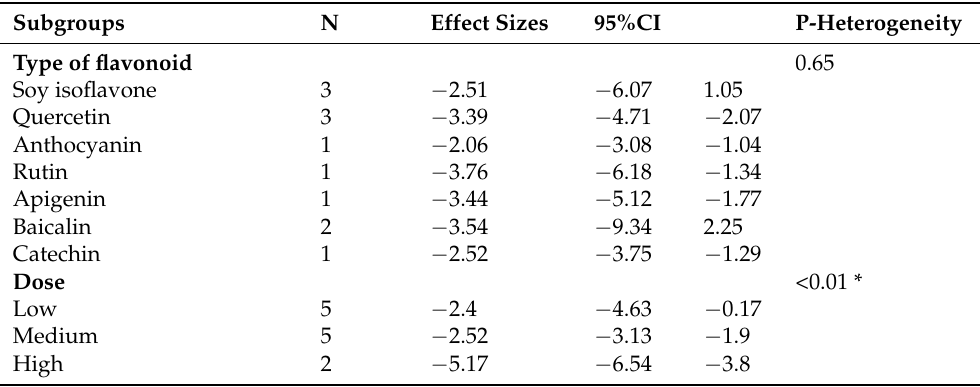
Table 4. Subgroup analysis of flavonoids effect on